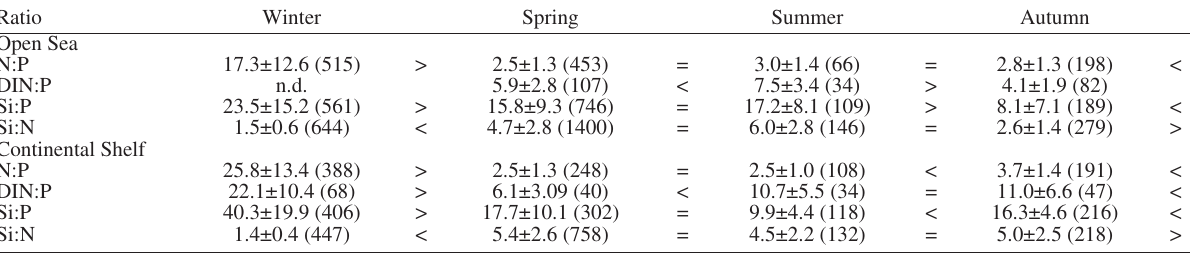
Table 3. – Seasonal changes in the nitrate (N), dissolved inorganic nitrogen (DIN) and silicate (Si) vs. phosphate (P), and silicate vs. nitrate ratios in surface water (0 to 50 m depth). Ratios are shown as median±median absolute deviation; number of data between parentheses. Significant differences ( p ≤ 0.05) are indicated with “<” or “>”, while the absence of statistically significant differences is indicated with “=”. “n.d.”, no data. Ratio Winter Spring Summer Autumn Open Sea N:P